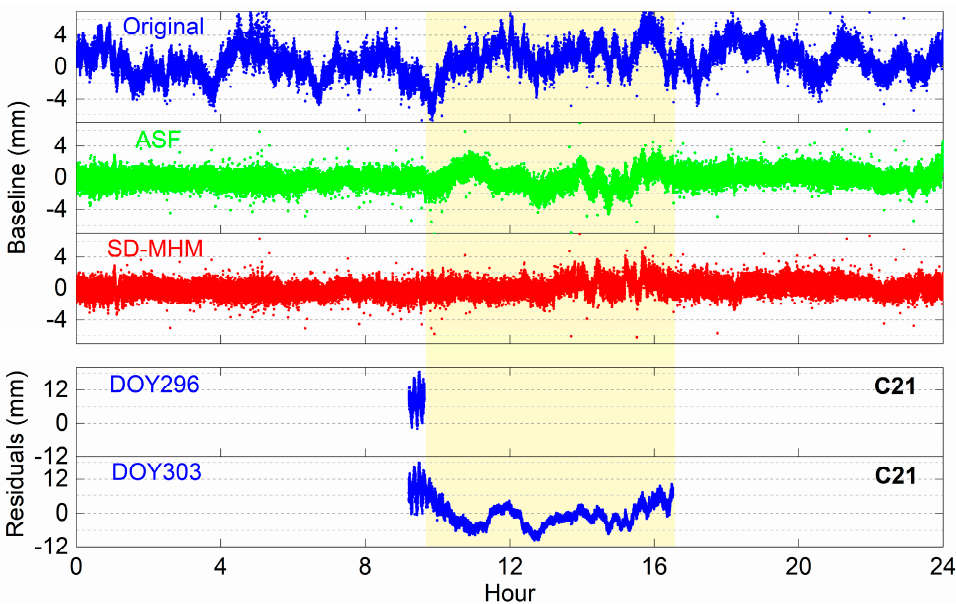
Figure 9. The original baseline series, ASF, and SD-MHM corrected series and C21 single-difference residuals at the adjacent periods.